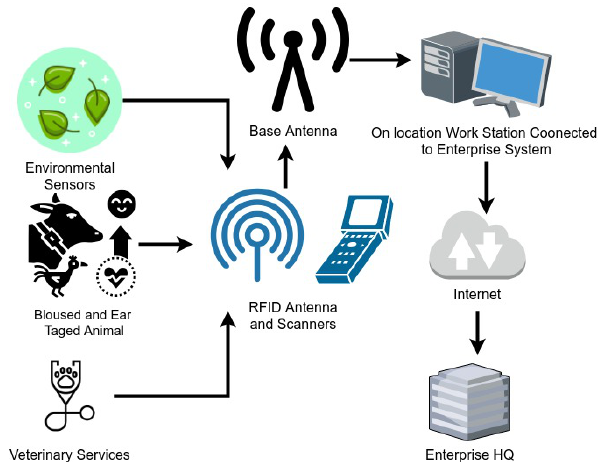
Figure 7. Farm Management System.